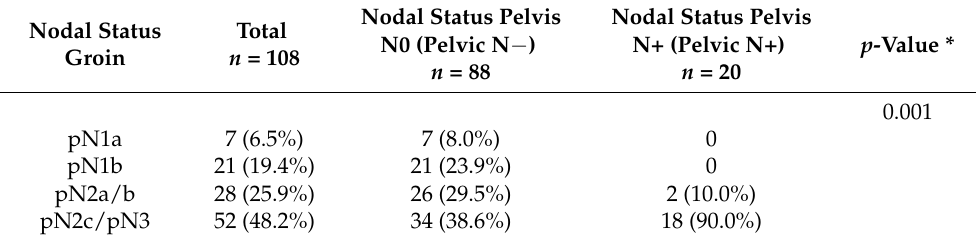
Table 2. Relation between inguinal and pelvic nodal status ( n = 108 patients with known pelvic status).